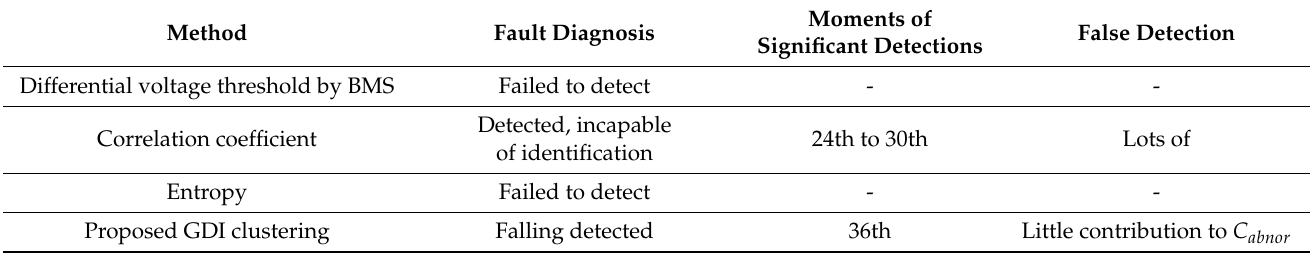
Table 4. Performance of the Methods in Case